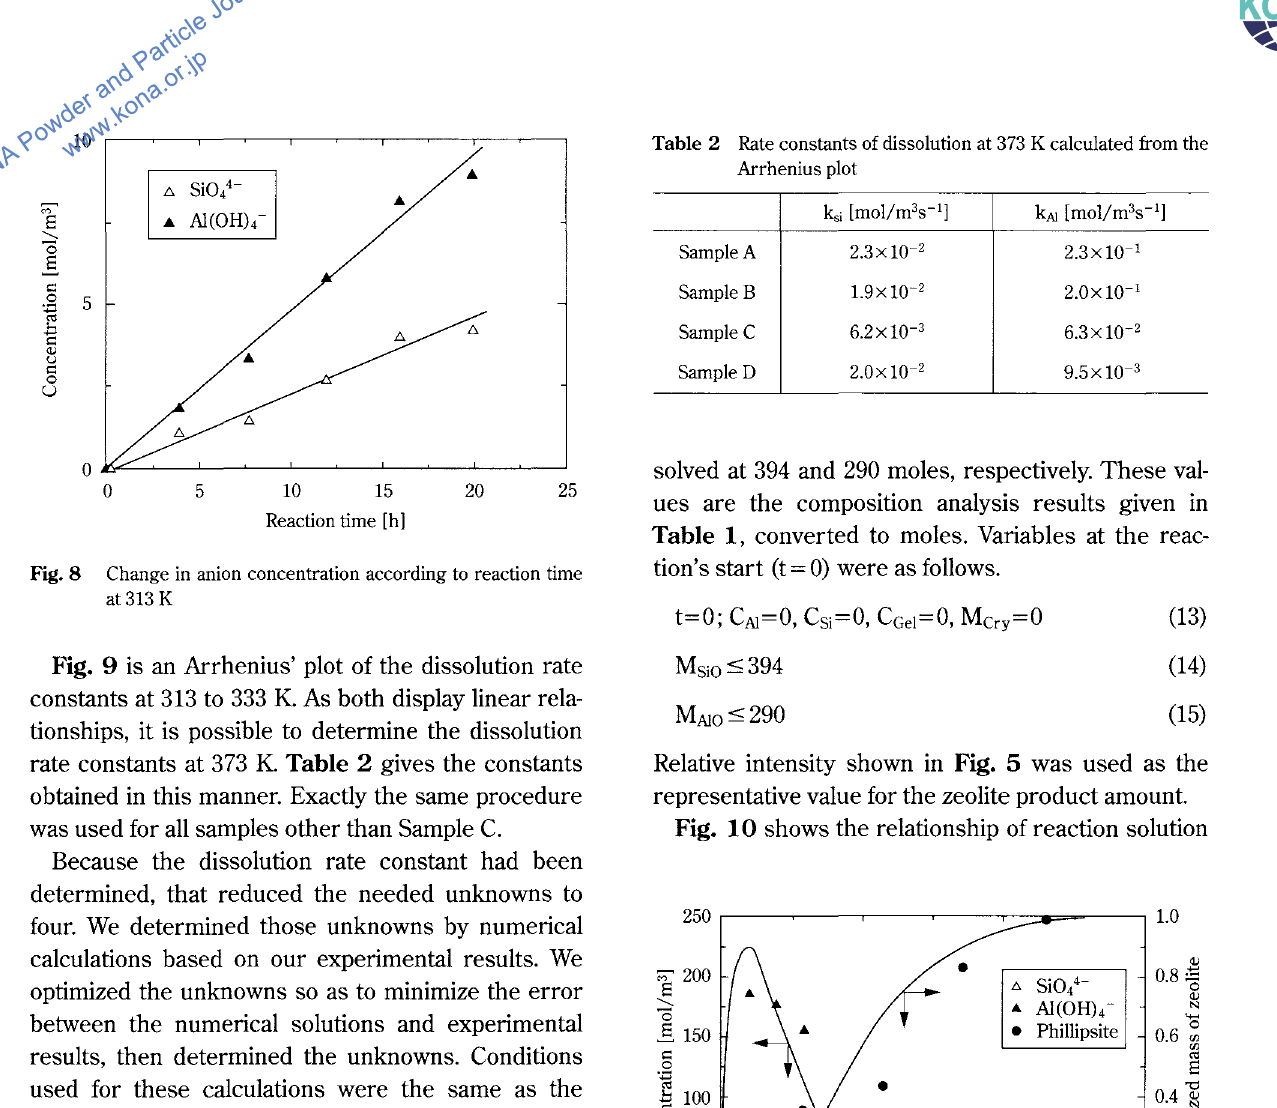
Table 2 Rate constants of dissolution at 373 K calculated from the Arrhenius plot k,; [mol/m 3 s- 1]